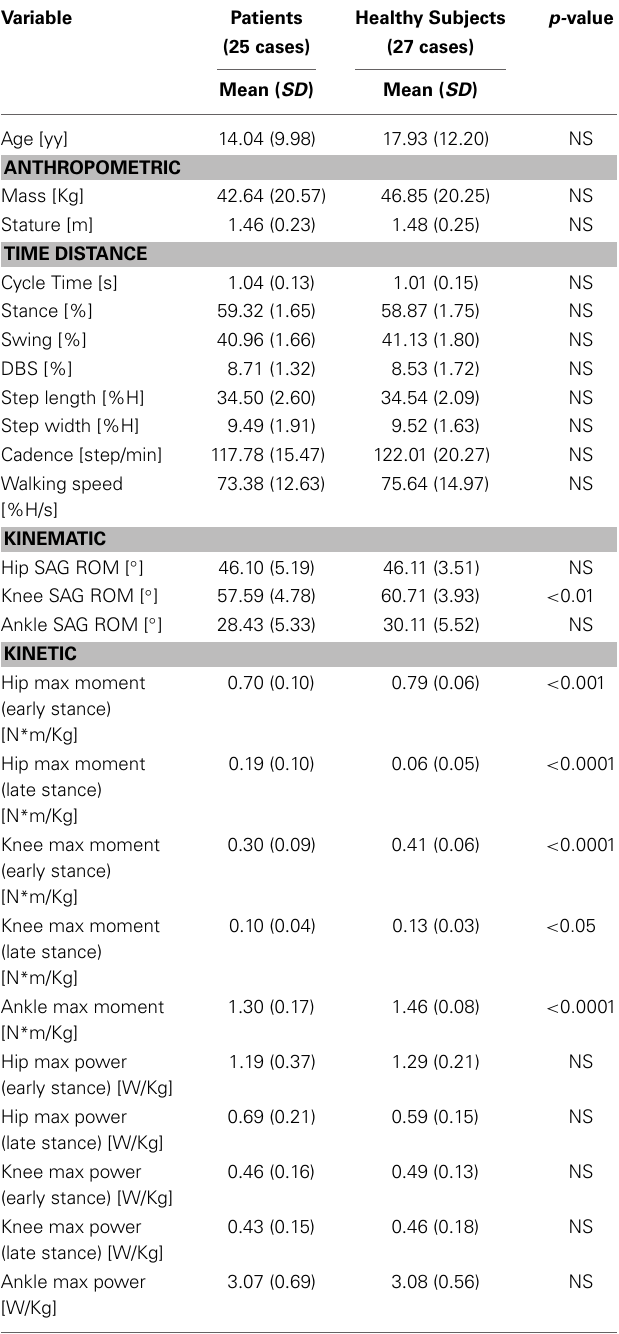
Table 2 | Spatio-temporal, kinematic, and kinetic parameters in patients and in